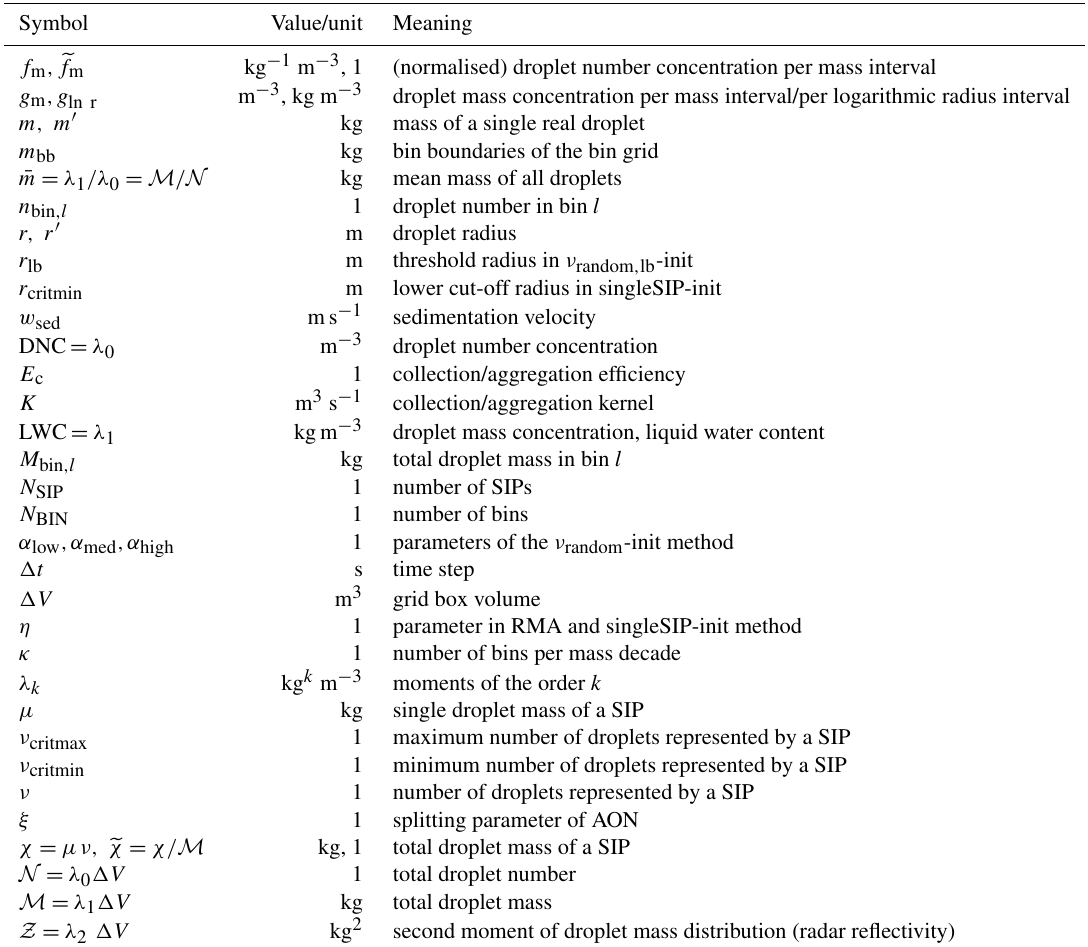
Table 2. List of abbreviations. AON All-or-nothing algorithm AIM Average impact algorithm Droplet size distribution LCM Lagrangian cloud model Update on the fly RedLim Reduction limiter Simulation